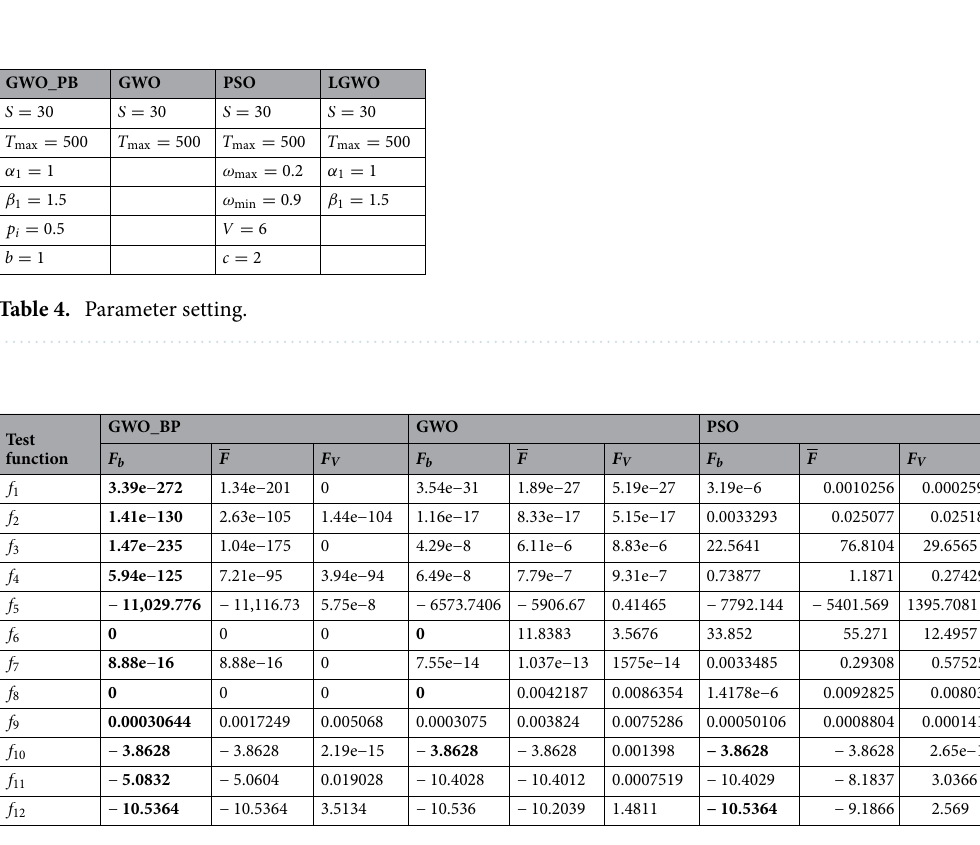
Table 5. The optimization results of GWO_BP, GWO and PSO. Significant values are in [bold].